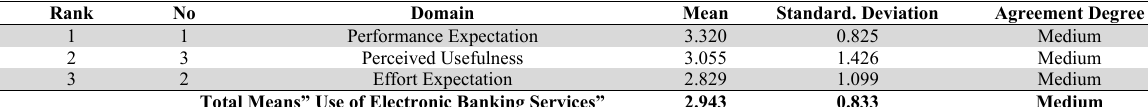
Means and standard deviation for each